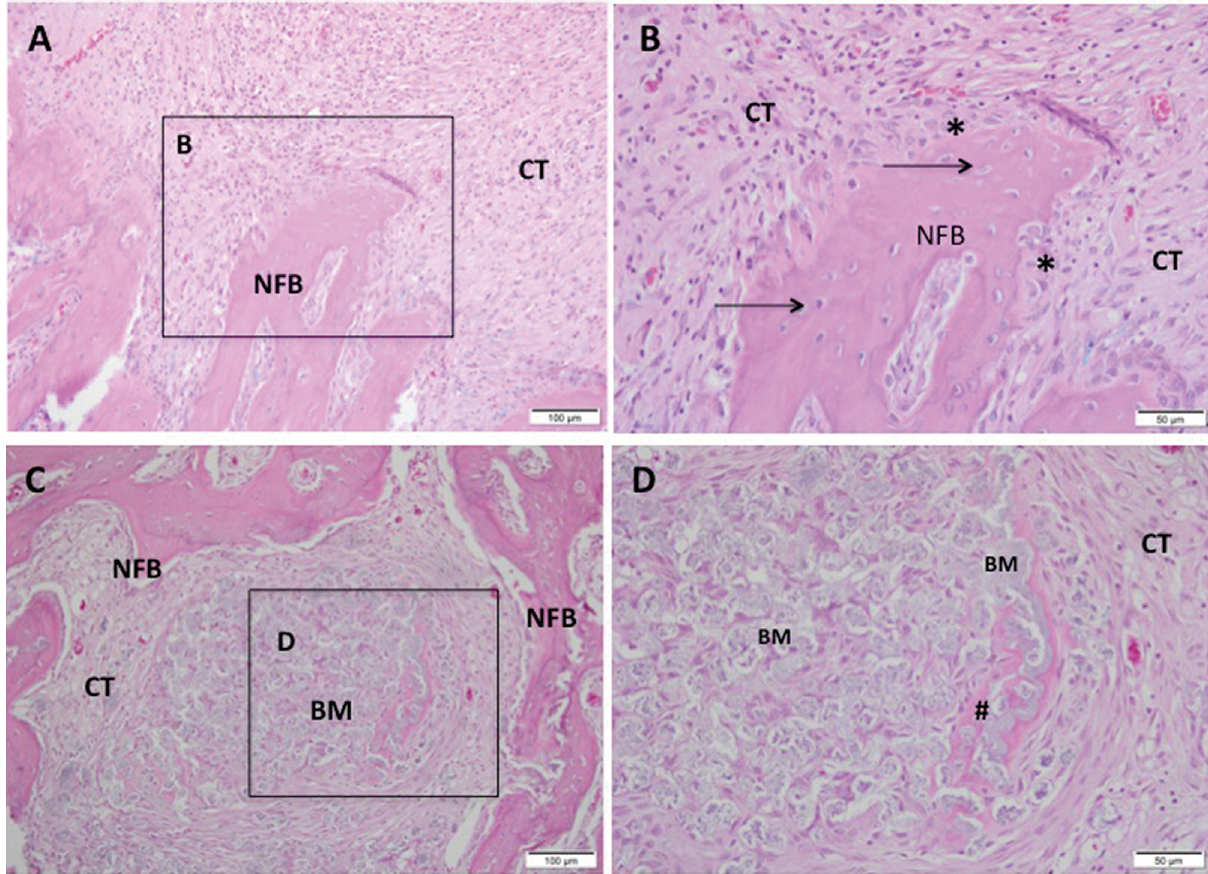
Figure 4- Representative photomicrographs of alveolar socket after 42 days. A and B: CHA group and C and D: SrCHA group. A and B: observe the presence of newly formed bone (NFB) with osteocytes (arrow) and osteoblastic paving (*) permeated by fibrocellular connective tissue (CT), with few inflammatory cells and absence of biomaterial (BM). C and D: presence of new-formed bone with connective tissue at the surroundings containing fragmented biomaterial and peripheric osteoid (#). A and C: 20-fold magnification and B and D: square with 40-fold magnification taken from A and C, respectively. BM: Biomaterial, NFB: Newly Formed Bone, CT: Connective Tissue; #: Osteoid, *: Osteoblasts. Hematoxylin and eosin stained. Bar: A and C: 100 µm; B and D: 50